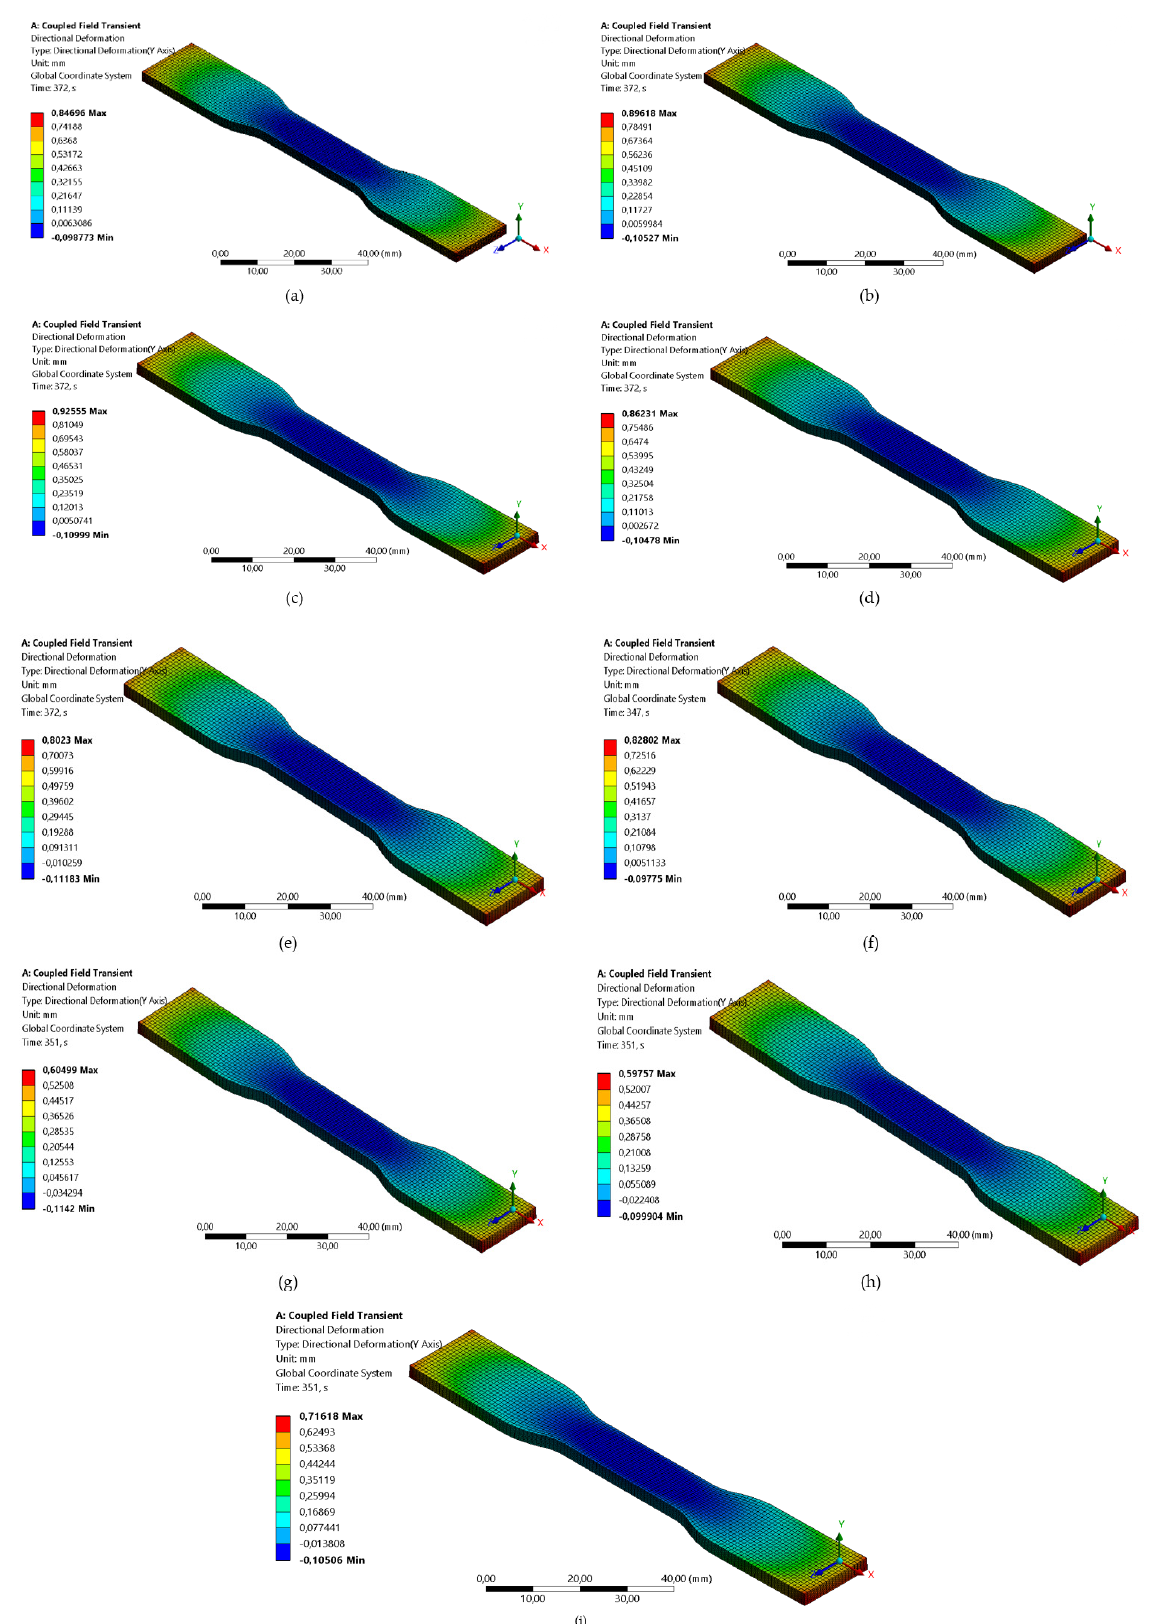
Figure 7. Directional deformation along the y -axis for run: ( a ) 1; ( b ) 2; ( c ) 3; ( d ) 4; ( e ) 5; ( f ) 6; ( g ) 7; ( h ) 8; ( i ) 9.